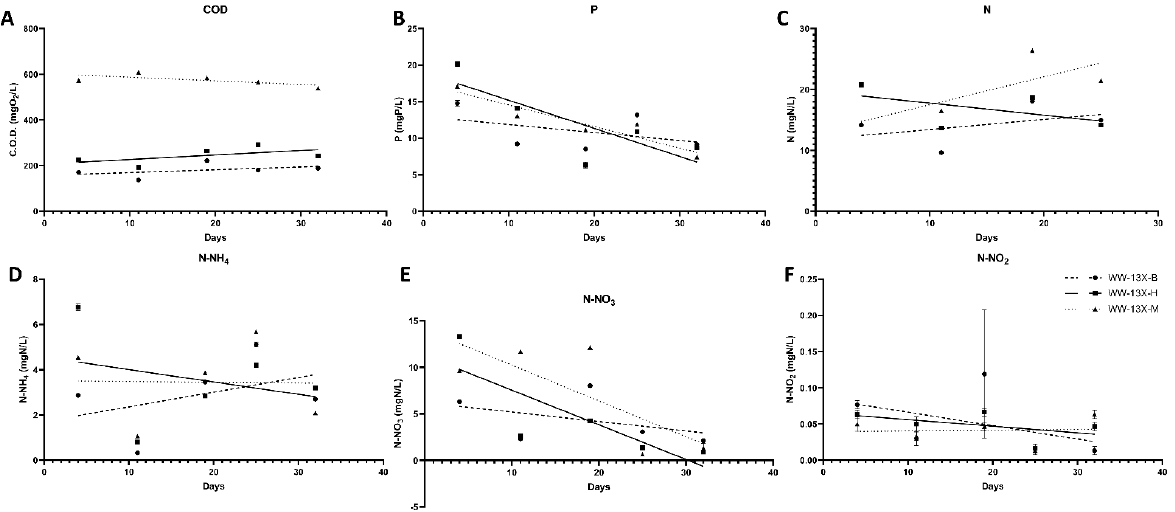
Figure 4. Variation of physicochemical parameters during WWT experiment using 3D-printed 13X biocarriers. ( A ) COD, ( B ) P, ( C ) N, ( D ) N-NH 4 , ( E ) N-NO 3 , ( F ) N-NO 2 .